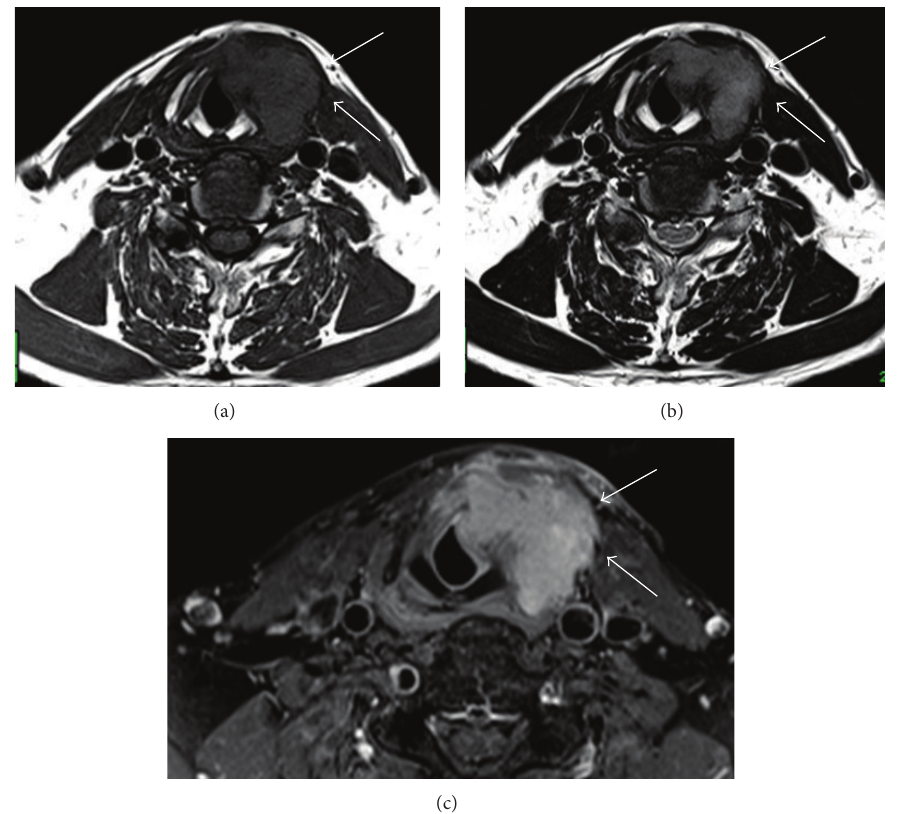
Figure 2: MRI revealed the same findings as CT scanning: (a) a low-intensity area on T1-weighted images and (b) a nonhomogenous high- intensity area on T2-weighted images. (c) The tumor demonstrates high intensity on a postgadolinium contrast T1 image (arrow).